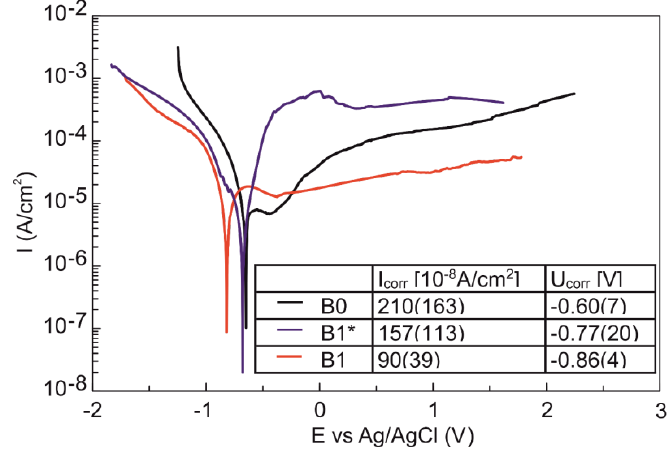
Figure 7. Potentiodynamic curves of Ti23Zr25Nb alloy after electrochemical etching (B1*) and electrochemical deposition (B1) in contrast to non-modified Ti23Zr25Nb alloy. The surface free energy and contact angles for an electrochemically etched and deposited sample